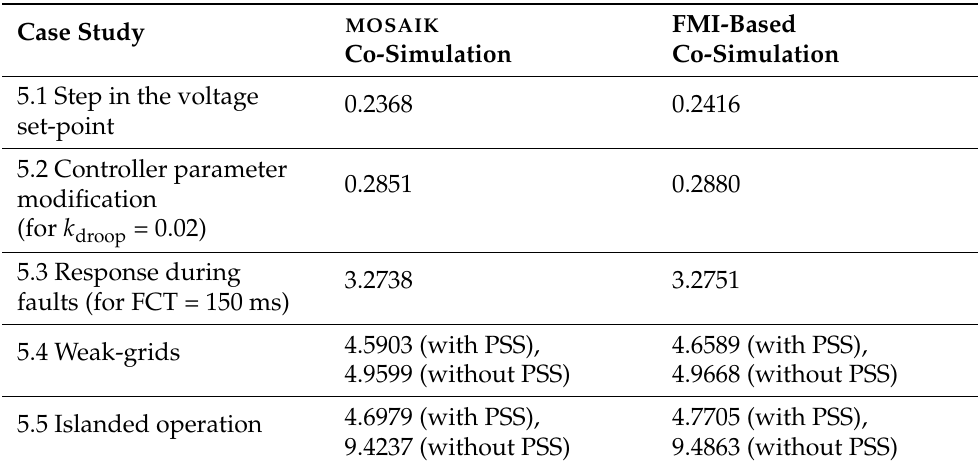
Table 1. Root square deviation (RSD) [p.u.] for the applied case studies in Section 5.1 to Section